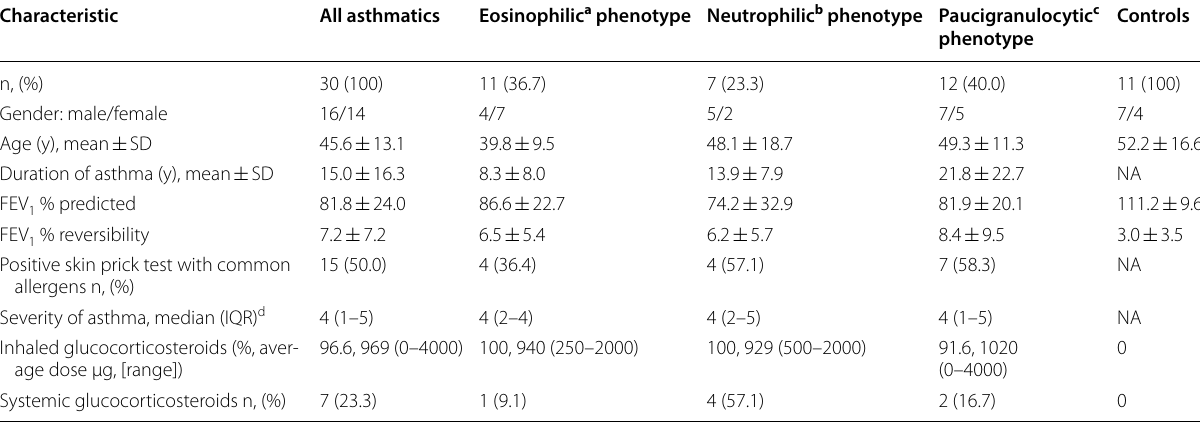
NA not applicable/available a Eosinophilic (E), > 2% of eosinophils and < 3% of neutrophils in BALF b Neutrophilic (N), < 2% eosinophils and > 3% neutrophils in BALF c Paucigranulocytic (P), < 2% of eosinophils and < 3% neutrophils in BALF d IQR, interquartile range; asthma severity stages according to GINA (Global Initiative for Asthma)